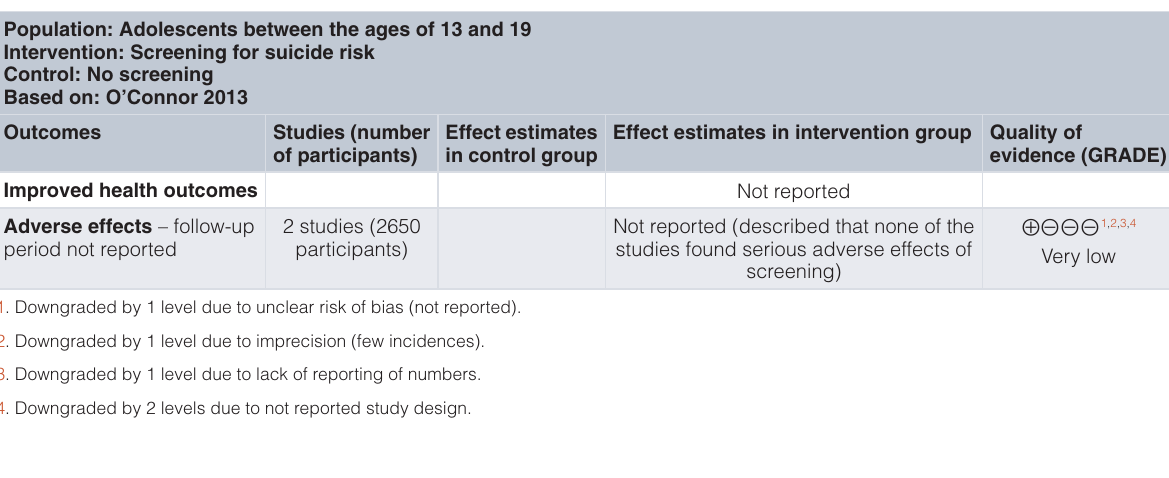
Table 7. GRADE-assessment: Interventions for existing self-harm: therapeutic assessment versus treatment as usual (TAU). Population: Adolescents, 12 to 18-year olds referred for a psychosocial assessment following an episode of self-injury or self- poisoning irrespective of intent Intervention: Therapeutic assessment Control: TAU Based on: Hawton